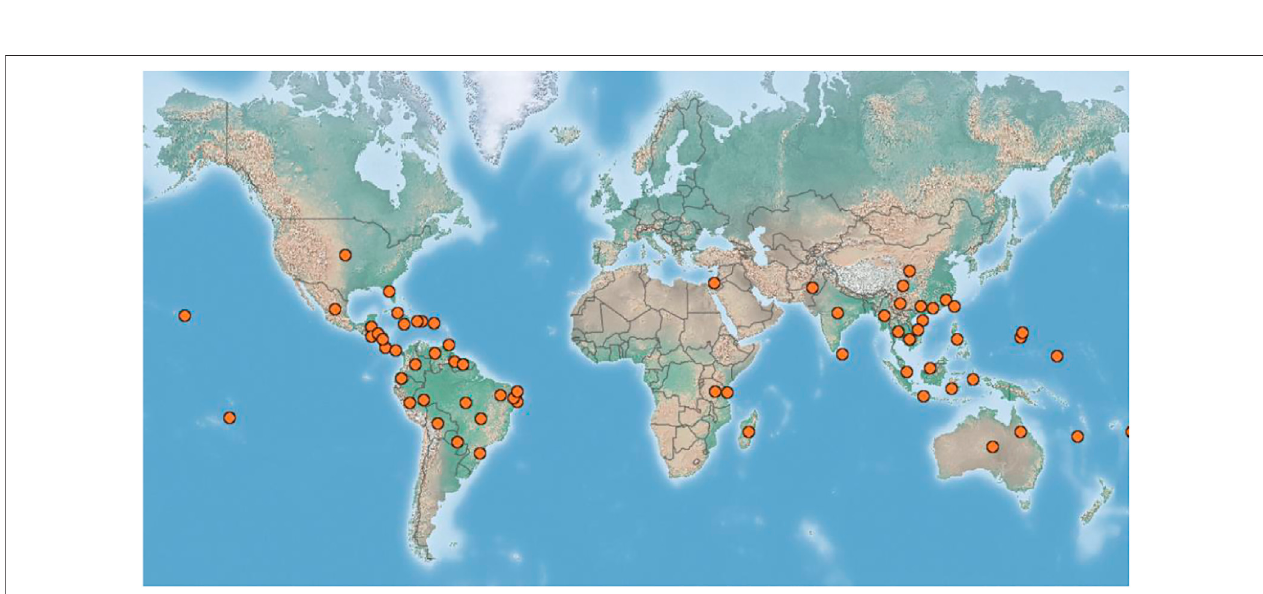
FIGURE 2 | Geographical distribution of A. carambola throughout the world (https://www.cabi.org/isc/datasheet/8082).